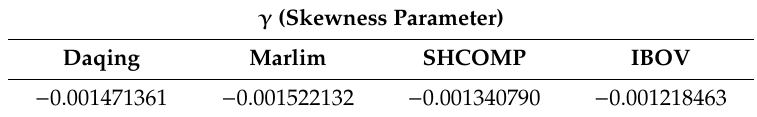
Table A16. MNIG Skewness parameter γ for Vector 4: Daqing, Marlim, SHCOMP, IBOV.